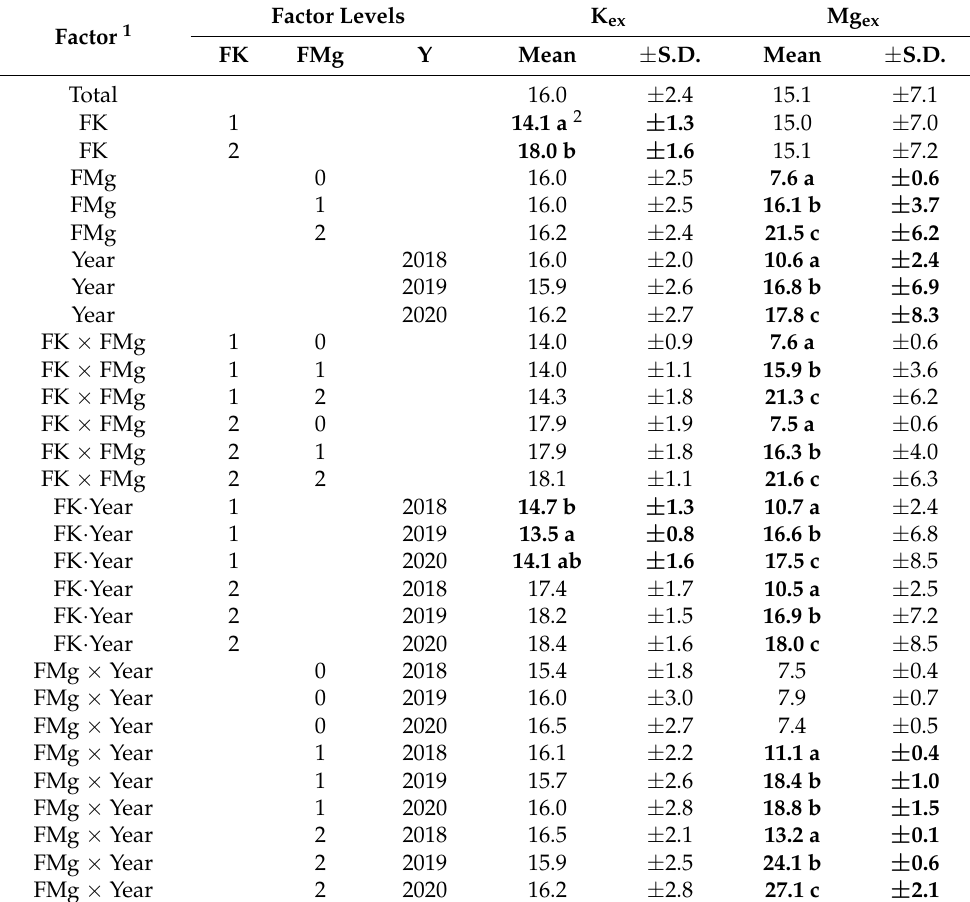
Table 9. Soil exchangeable K and Mg contents (mg/100 g o.d.soil) in the microplot field experiment with potatoes with potassium (FK) and magnesium fertilization